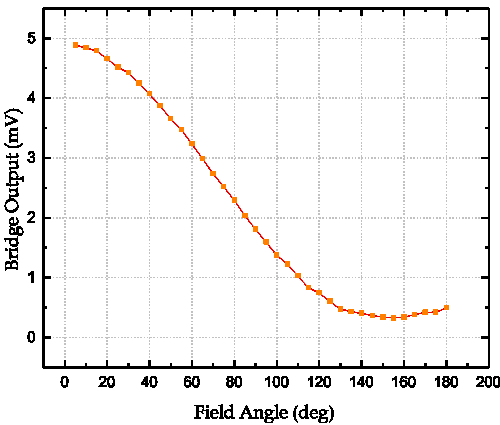
Figure 5. Bridge output as a function of the applied field direction.